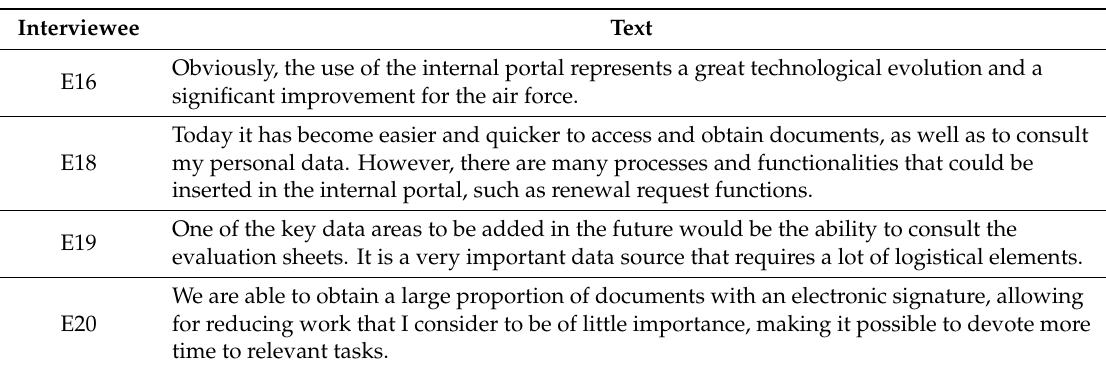
Table 4. Content analysis—Impact of the internal portal on the Air